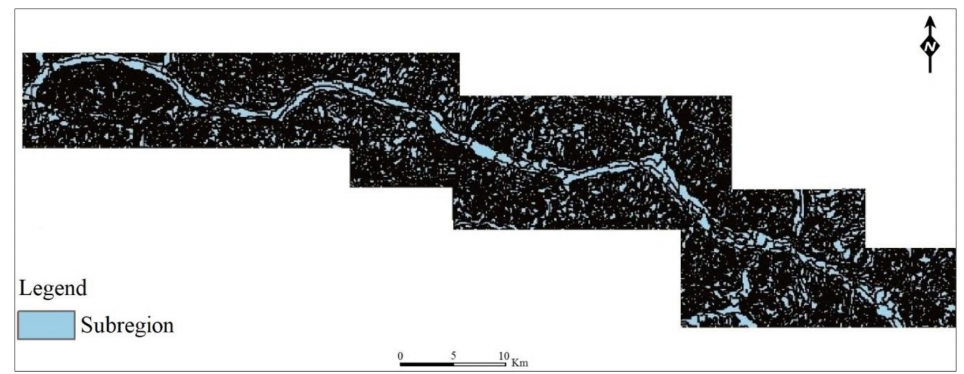
Figure 3. Multiresolution texture segmentation results for Zigui–Badong County (based on Landsat-8 TM4, TM3, and TM2 band data; division into 2279